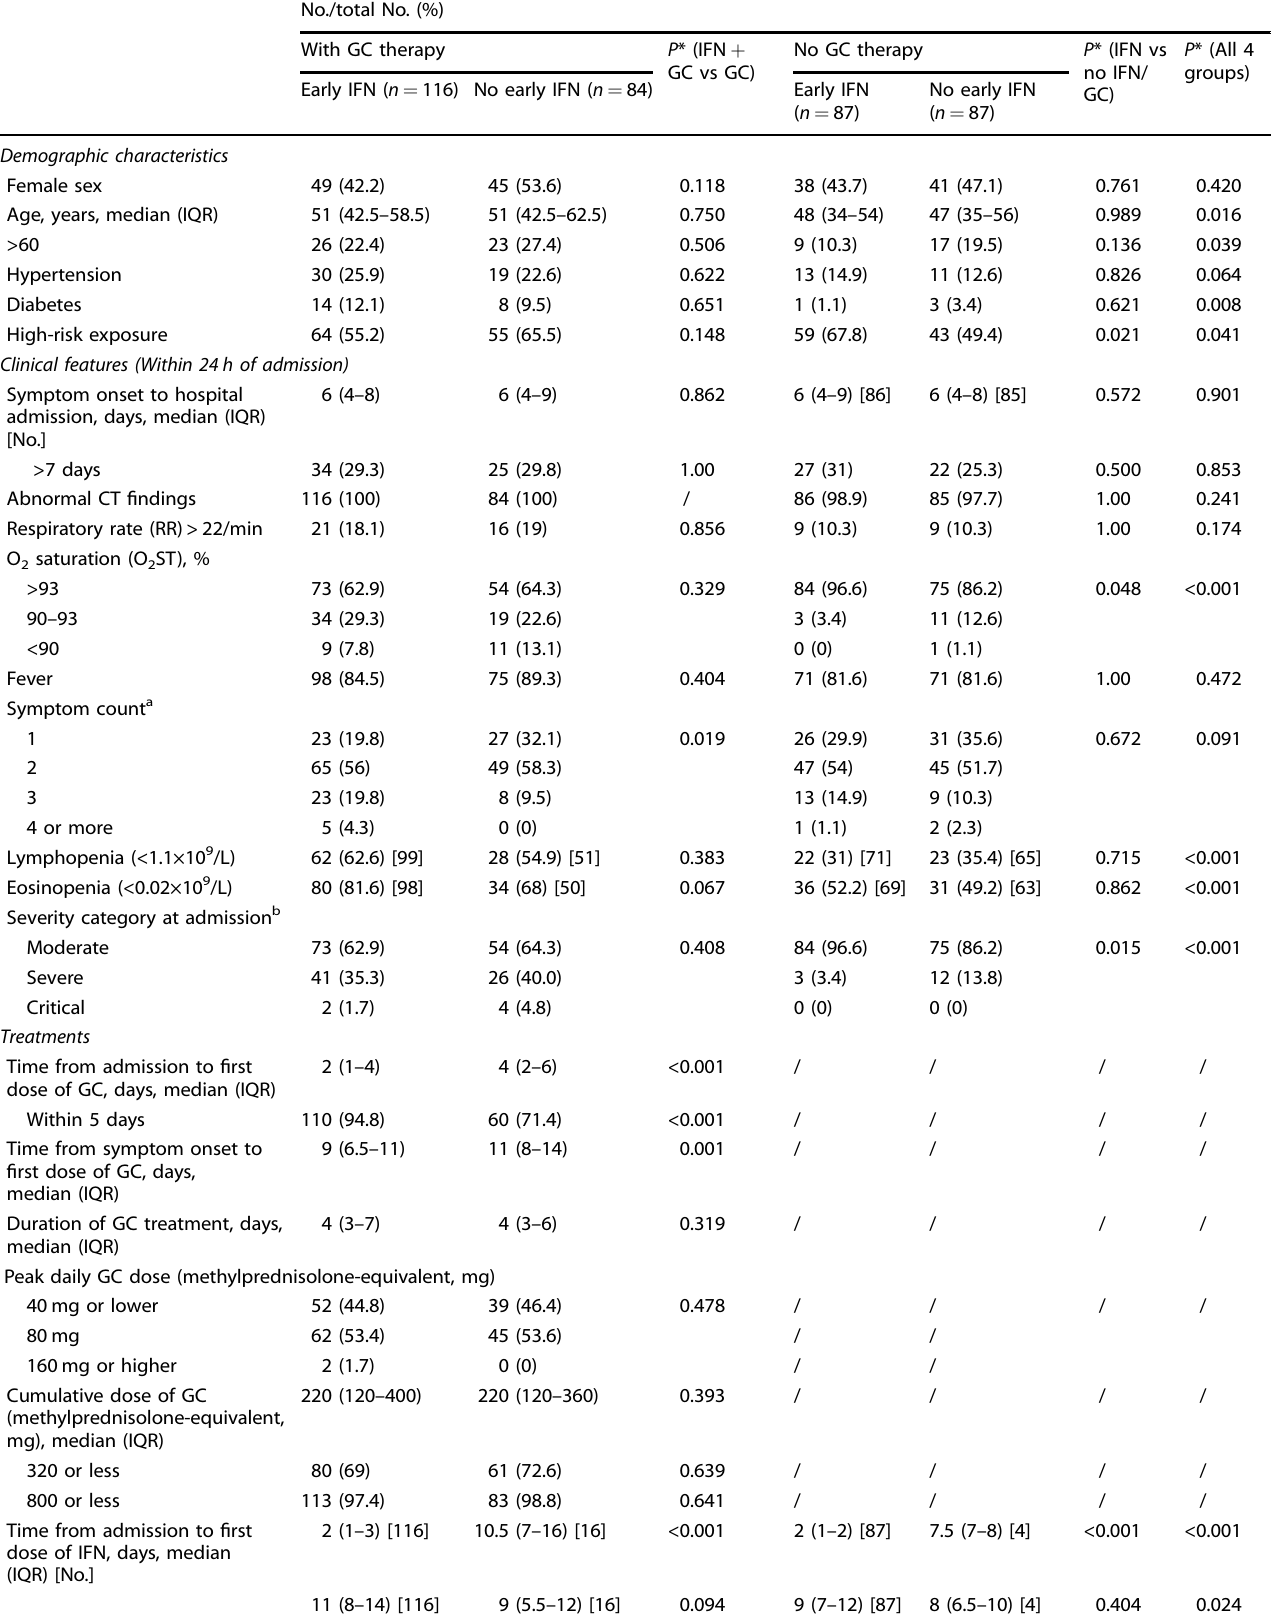
Table 1. Characteristics of survivors by treatment